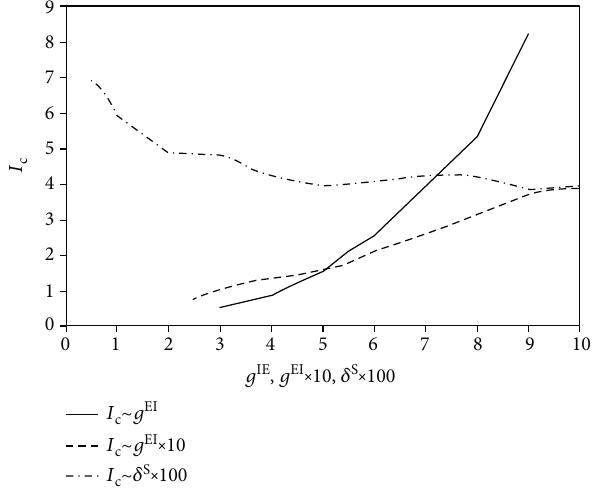
Figure 9: Dependency of information encoding e ffi ciency on (a) strength of the synapse from inhibitory neurons to excitatory neurons, (b) strength of the synapse from excitatory neurons to inhibitory neurons, and (c) standard deviation of the